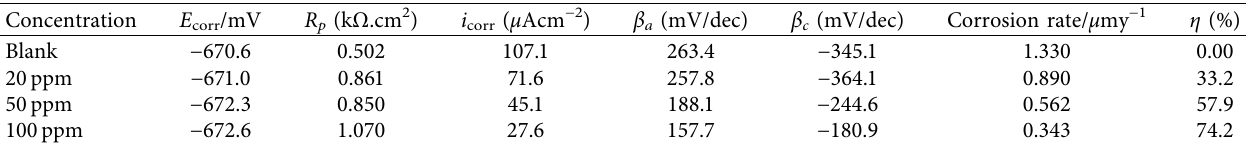
Figure 13: Potentiodynamic polarization curves of mild steel in a stagnant naturally aerated aqueous solution of 1M H concentrations of PSA at 25 ° Table 5: Potentiodynamic polarization parameter of steel after 1hr. of electrode immersion in a stagnant naturally aerated solution of 1 M H 2 SO 4 at 25 ° C. containing diferent concentrations of PSA.